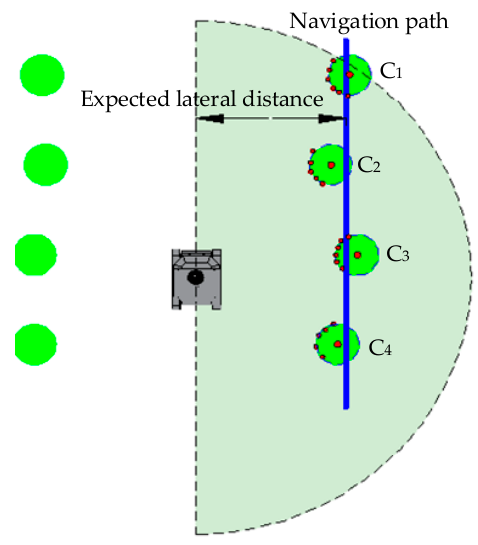
Figure 6. Fitting the navigation path.